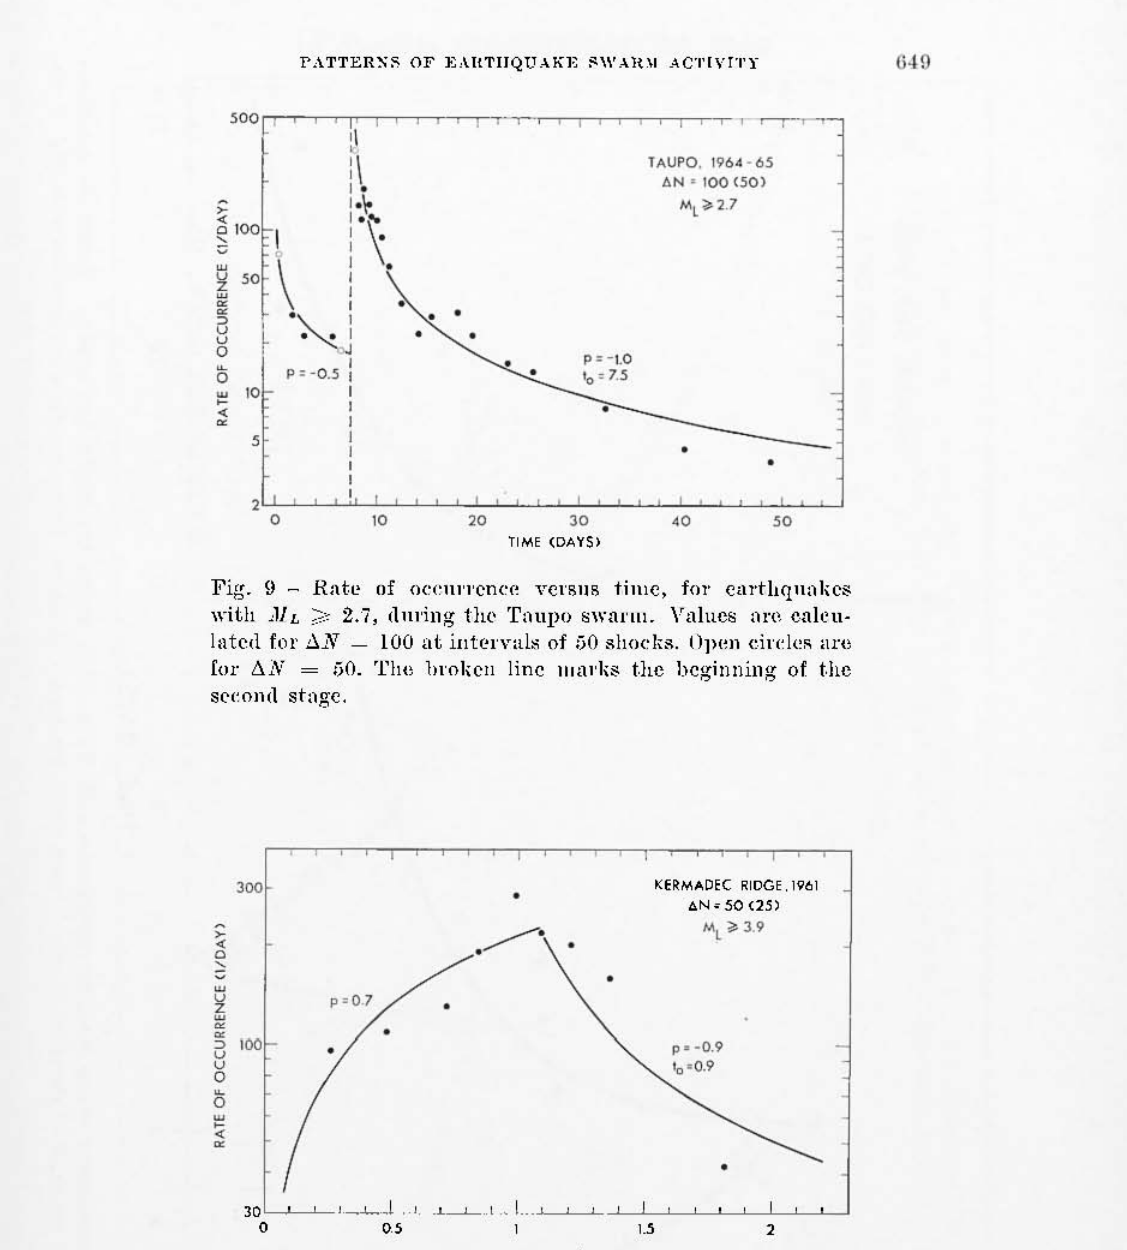
F ig. 9 - Rate of O{T1l1'1'cne{' VCI'SUS tilllC, fol' CHl'thqnnl,c;;: with Jh ?_, 2.7, dnl'ing the Tnupo 8\\"nl'll1. VnLue8 nl'\\ enLl'u· latcd for J::,.N _ 100 nt intel'vaL~ of ;:;0 RhoekR. ()ppn eil'd('~ are [or !'liV = ;:;0. Tlw hml,Cll linl' IIltll'I,;;: t.he hl'ginning of t.lte sceond